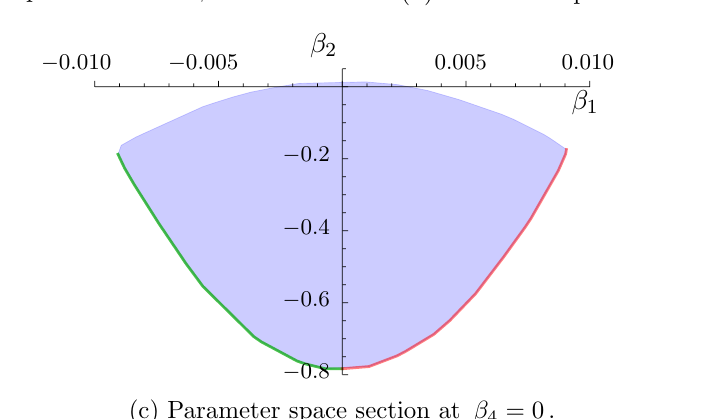
Figure 4. Three slices of the three-dimensional parameter space ( (cid:12) 1 ; (cid:12) 2 ; (cid:12) 4 ) describing regular deviations around the N = 1 , SU(3) vacuum of table 1 in the